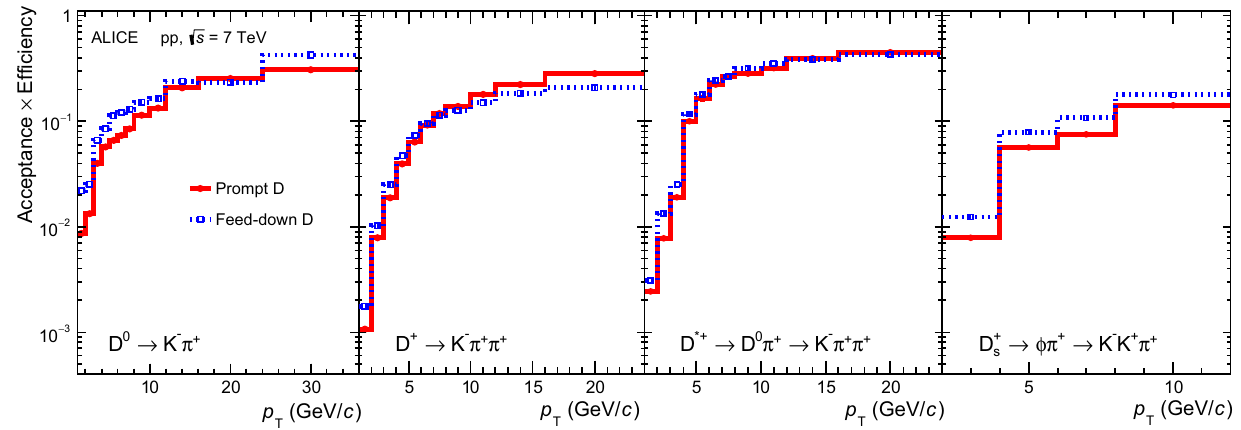
Fig. 2 Acceptance × efficiency for D 0 , D + , D ∗+ and D + s mesons, as a function of p T . The efficiencies for prompt ( solid lines ) and feed-down ( dotted lines ) D mesons are